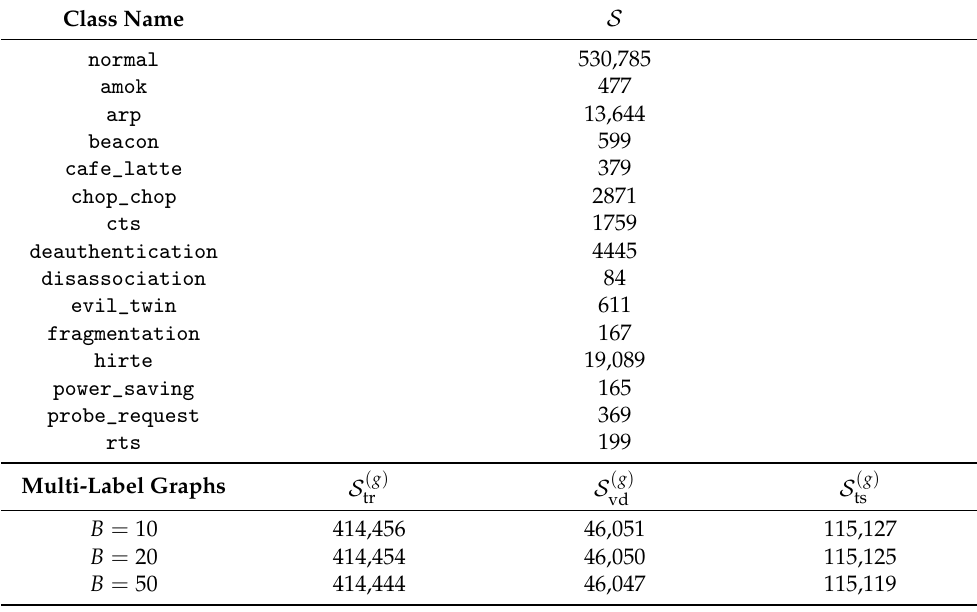
Table 3. Patterns and graphs’ distribution. Per label single instances’ distribution and multi-labeled network graph